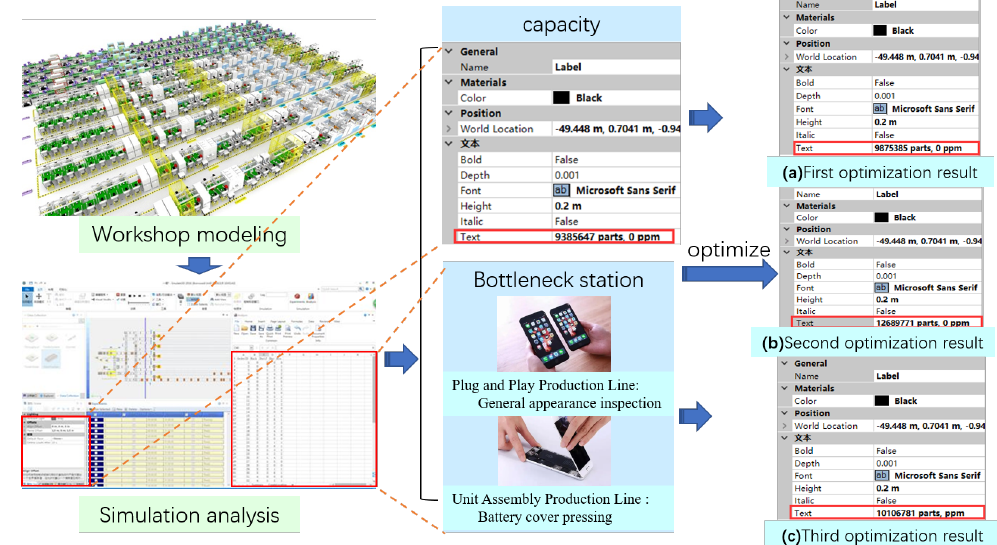
Figure 7. Simulation and optimization of workshop. ( a ) The results of optimization of all unit assembly lines in the workshop. ( b ) The result of optimization of all plug and play assembly lines and unit assembly lines simultaneously. ( c ) The result of iterative